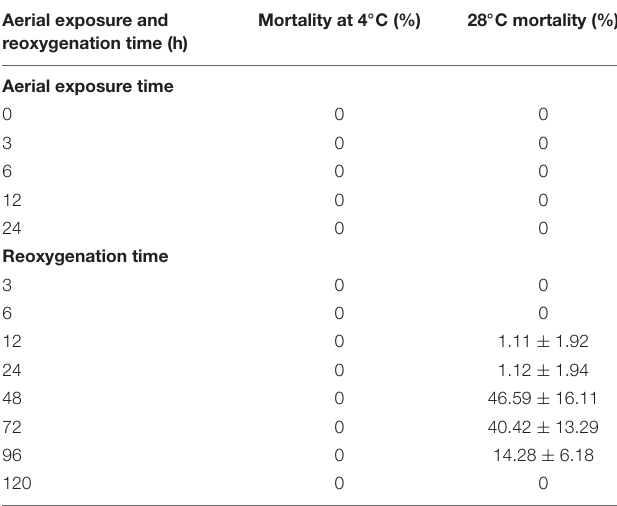
TABLE 1 | Mortality of clams under aerial exposure at low and high temperatures for 24 h and after reoxygenation for 120 h. Aerial exposure and Mortality at 4 ◦ C (%) 28 ◦ C mortality reoxygenation time (h)